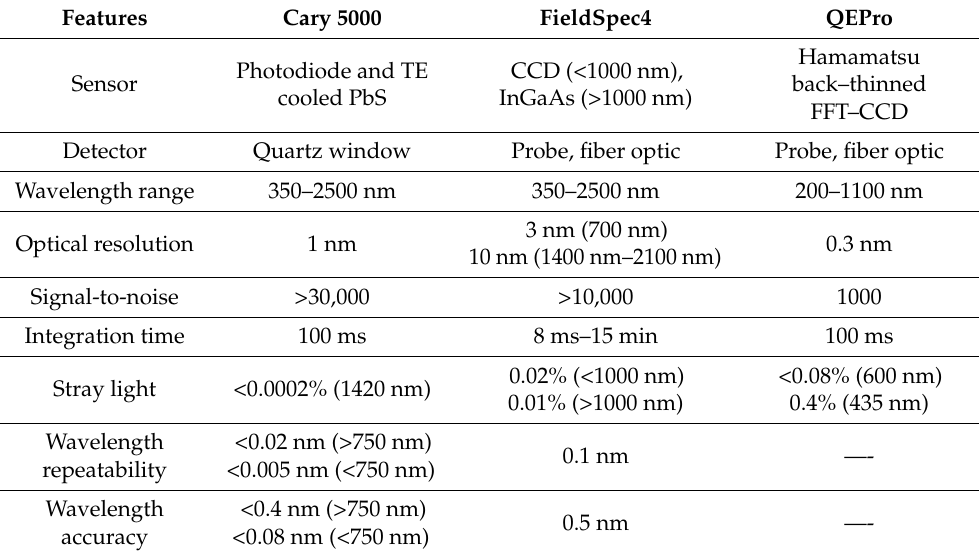
Table 2. The specifications of spectrometers used in this